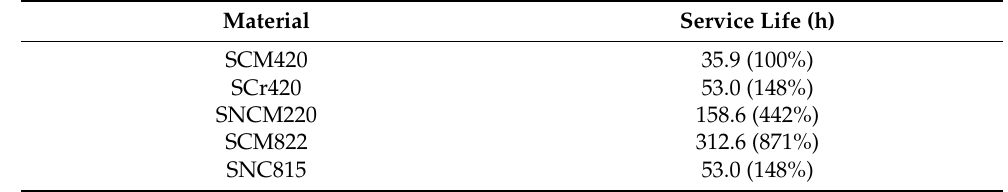
Table 6. Results of service life analyses for the range shift A gears with different materials.